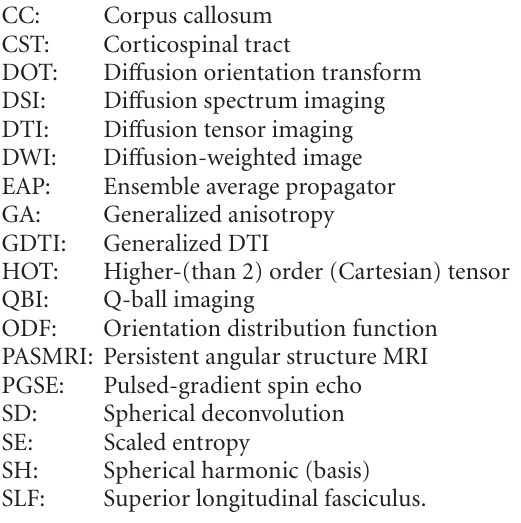
indicates that the truncation in the Taylor expansion has the e ff ect of underestimating the true EAP in the